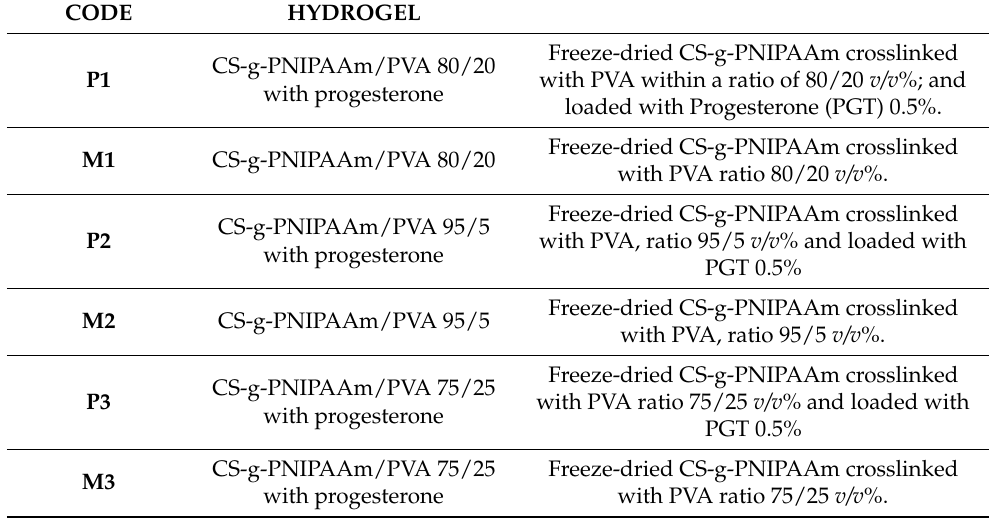
Table 3. List of hydrogel samples used for the